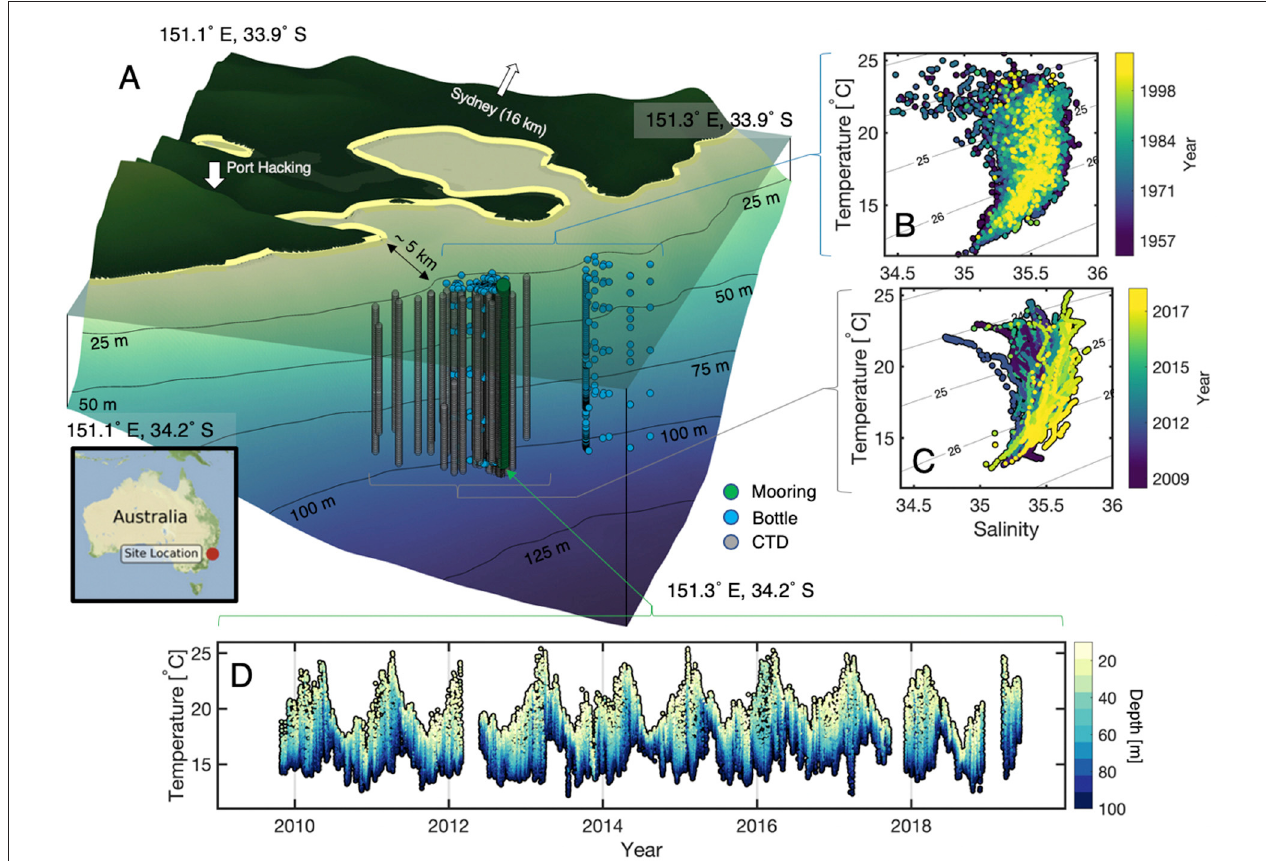
FIGURE 1 | (A) A 3D representation of the Port Hacking study site alongside its location in Australia. The locations and depths of the chosen bottle samples, CTD profiles, and the PH100 mooring are displayed. The black labeled contour lines represent the bathymetry in the area. The bottle (B) and CTD profile (C) T-S diagrams are shown, colored by the year in which they were collected, superimposed over potential density anomaly contours. The PH100 mooring temperatures as a function of time are displayed (D) , colored by the depth in which they were recorded.